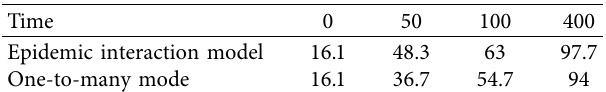
Figure 11: Individual attitude distribution under different interaction times of polarization model. (a) Epidemic interaction model. (b) One- to-many mode. Table 4: Statistical table of individual polarizability corresponding to the two modes in different interaction